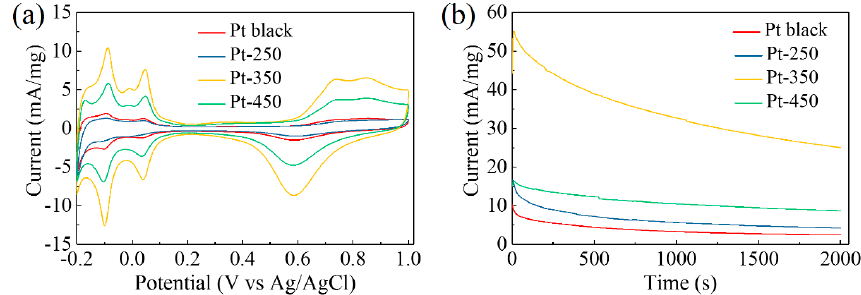
Figure 4. ( a ) Cyclic voltammograms were carried out in 0.5 M H 2 SO 4 with the potential between − 0.2 and 1 V at a scan rate of 50 mV · s − 1 . ( b ) Chronoamperometric curves at 0.6 V were recorded in an aqueous solution containing 0.5 M H 2 SO 4 and 0.5 M CH 3 OH.